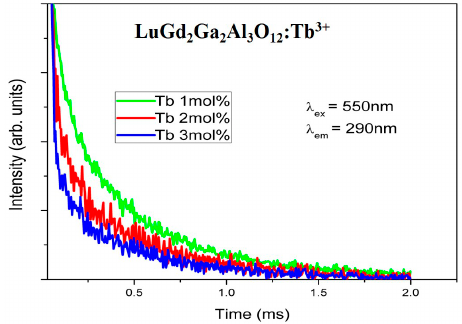
Figure 10. Decay time graph of LuGd 2 Ga 2 Al 3 O 12 : Tb 3+ .